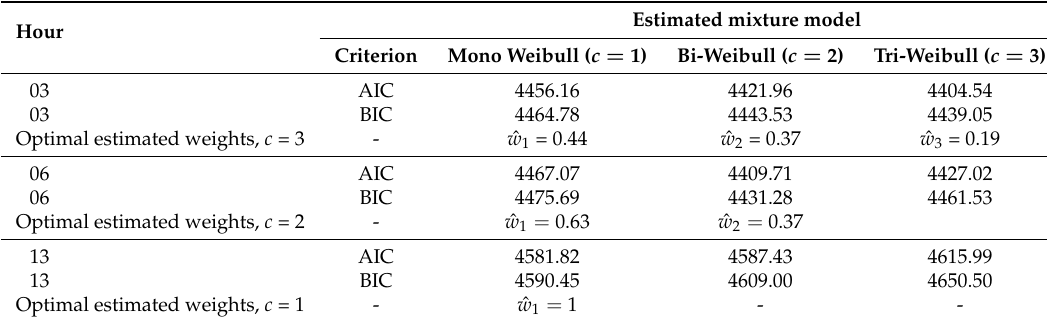
Table 1. For year 2010, 4th quarter and three different hours of the day, values of the information criteria for the estimated mixture models with c = 1, 2 and 3 components and the estimated weights for the optimum mixture model of aggregated wind power